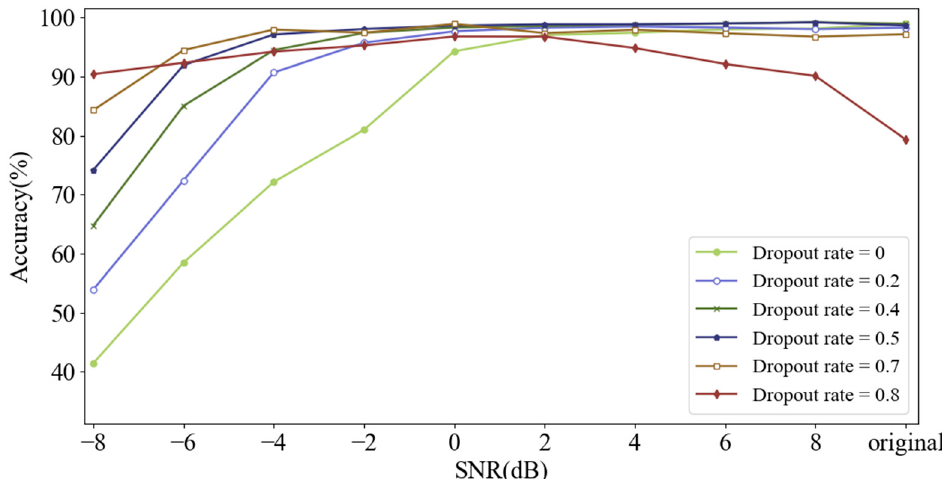
Figure 12. Diagnosis accuracy of CNN with different dropout rates testing on signals with different SNRs.